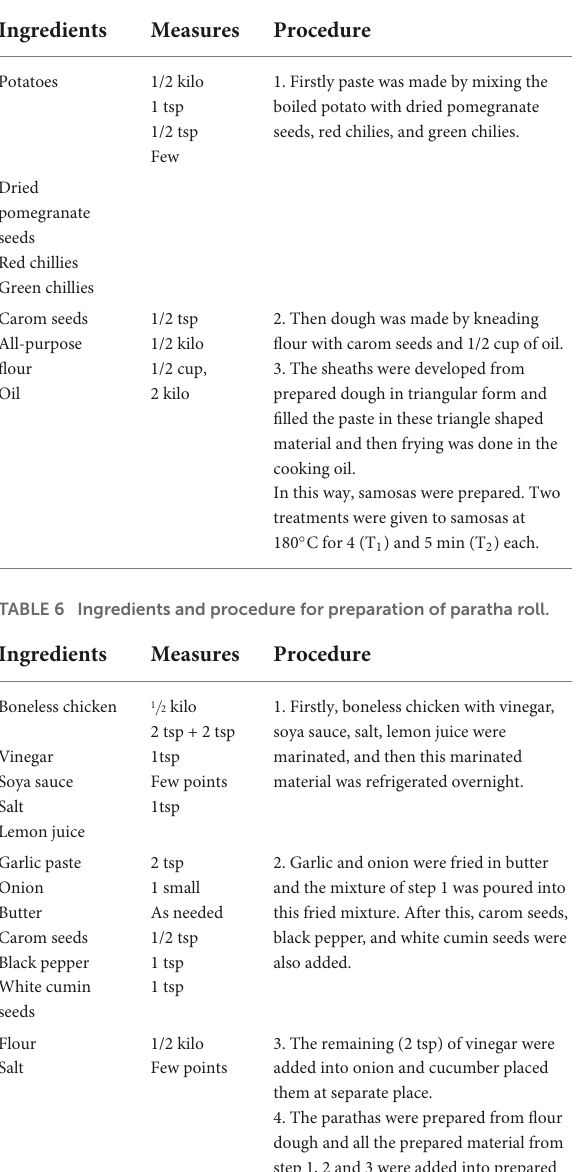
TABLE 7 Ingredients and procedure for preparation of potato cutlets.